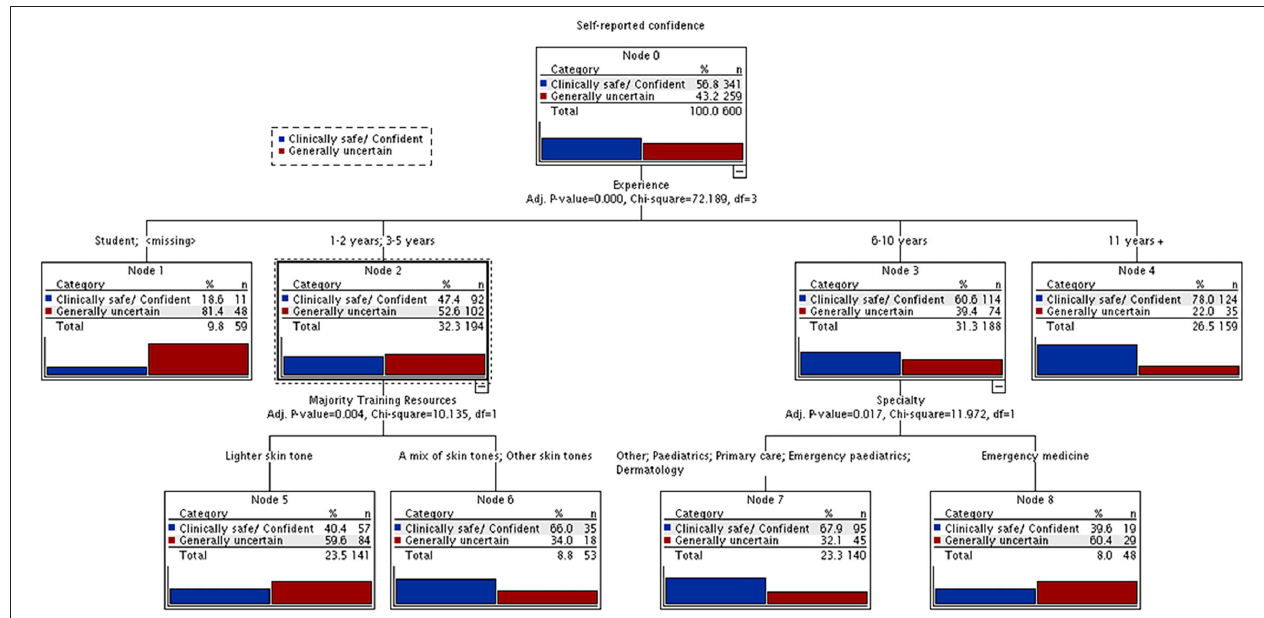
FIGURE 1 | CHAID (Chi-square Automatic Interaction Detector) was used to explore relationships between self-reported confidence and other factors. Blue bar, sometimes uncertain but clinically safe + confident across range of skin tones; Redbar, generally uncertain if